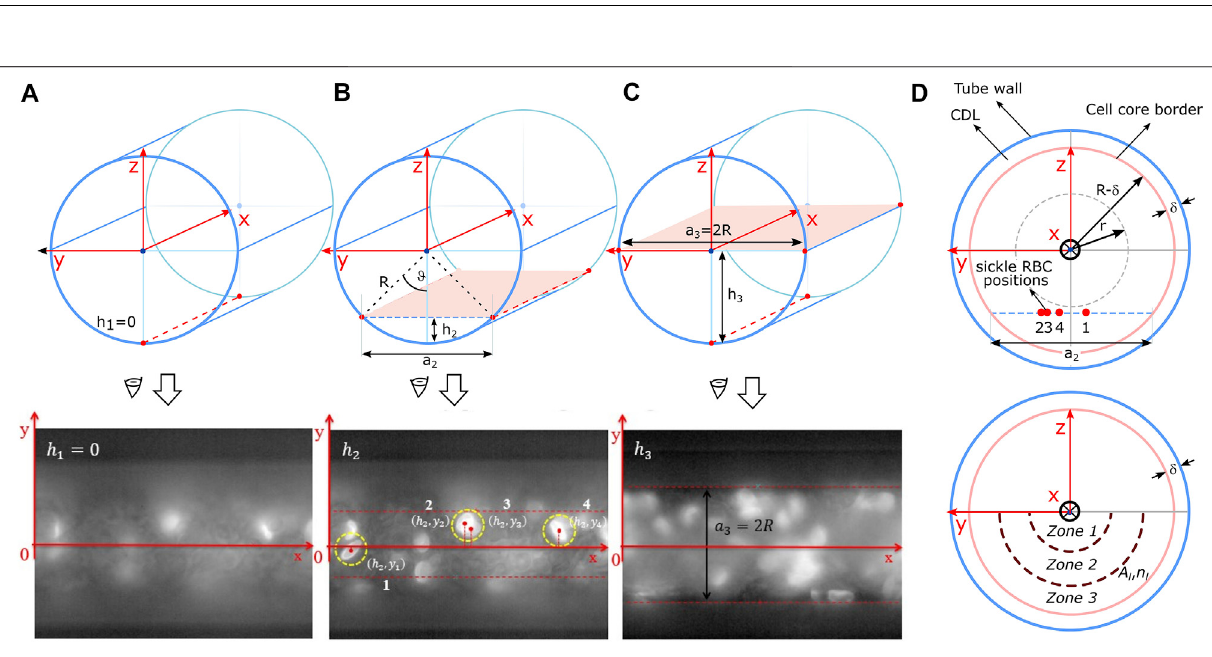
FIGURE 3 | The upper and lower panel in (A – C) represent the scanning process of the fl uorescence sRBC. In this case, the scanning goes from bottom of the capillary until its middle-plane. The spatial positioning of the sRBC, obtained on each scanning, was projected in the yz plane as shown in the upper panel in (D) . The bottom-semicircular area shown in the lower panel in (D) is divided in three zones called zones 1, 2, and 3, that have the same area A l . The number of sRBC inside each zone is n l